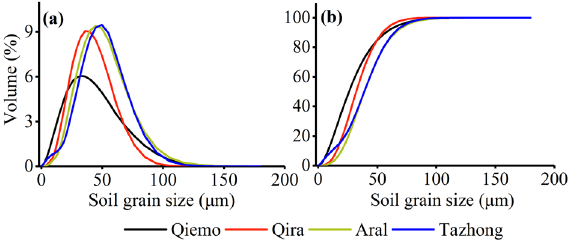
Figure 2. Variation characteristics of the soil grain size distribution at the different